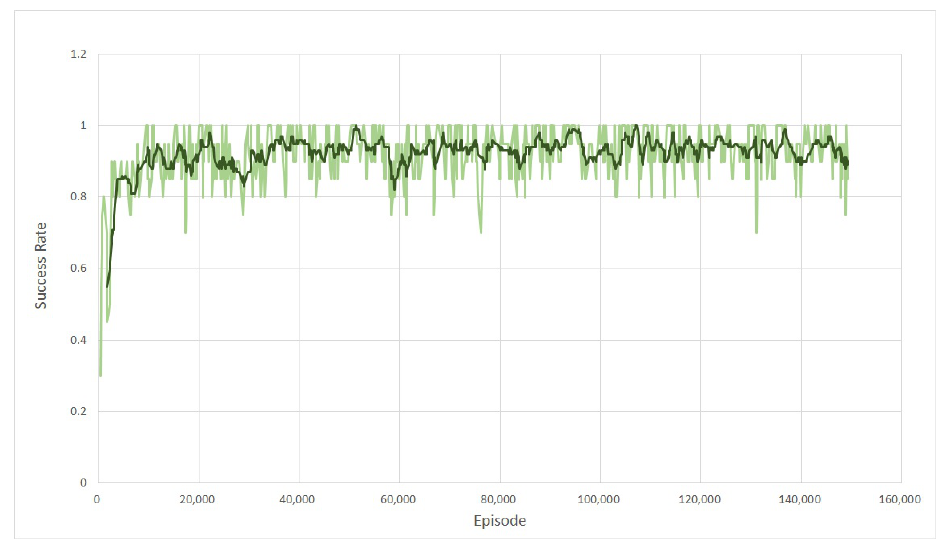
Figure 9. 3-DOF manipulator: success ration of reaching the goal point with HER.